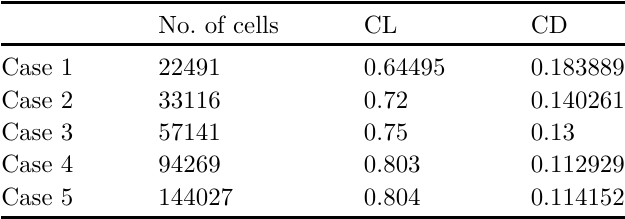
Table 3. Iterative process for the optimum number of